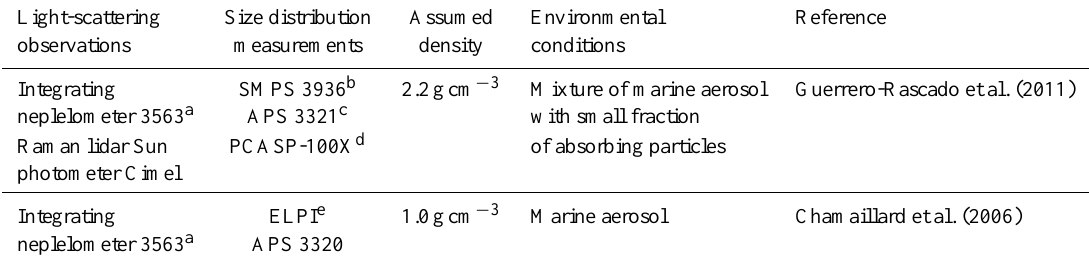
Table 1. Examples of the typical light-scattering data, measured particle number size distributions, and assumed values of particle density used for the optical closure studies under marine conditions. The listed examples illustrate a variety of instruments for measuring the light- scattering properties and size spectra, as well as a wide range of assumed values of particle density (from 1 to 2.2gcm − 3